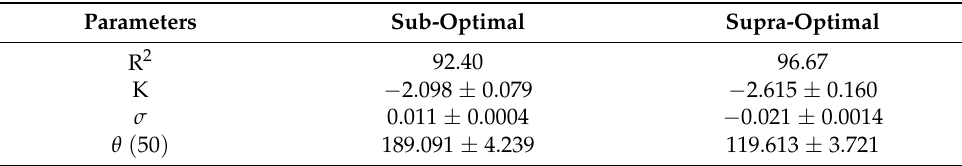
Table 1. Thermal time parameters estimated by the Probit analysis.